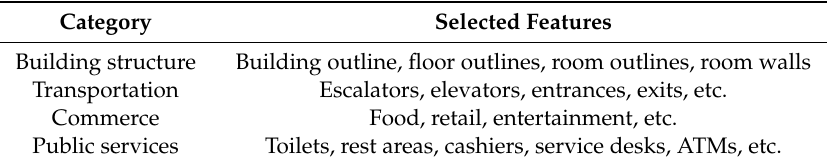
Table 1. Feature selection and classification